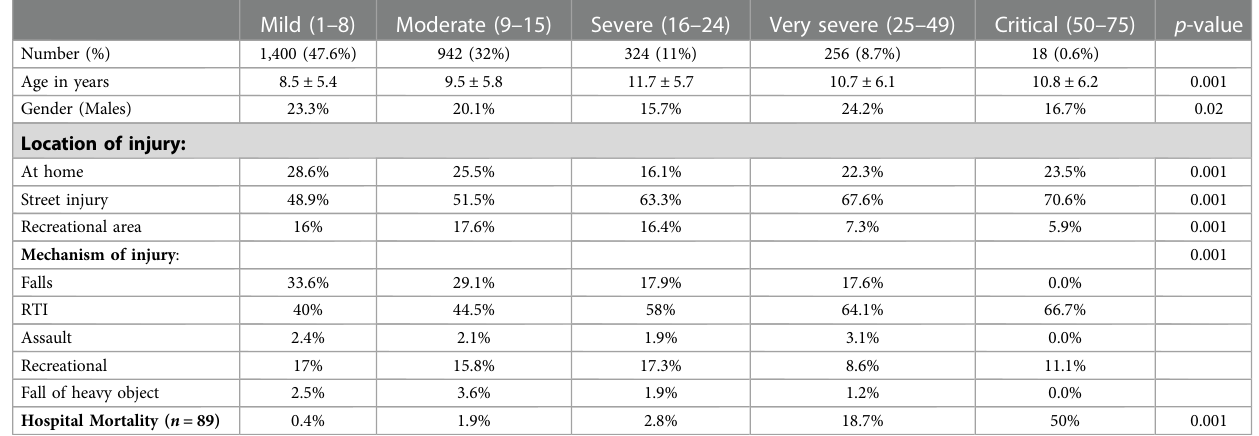
TABLE 5 Comparison based on the severity of injury (ISS) a